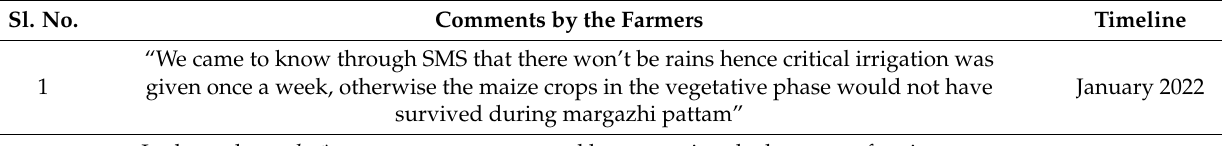
Table 3. Excerpts from the farmers’ survey are given